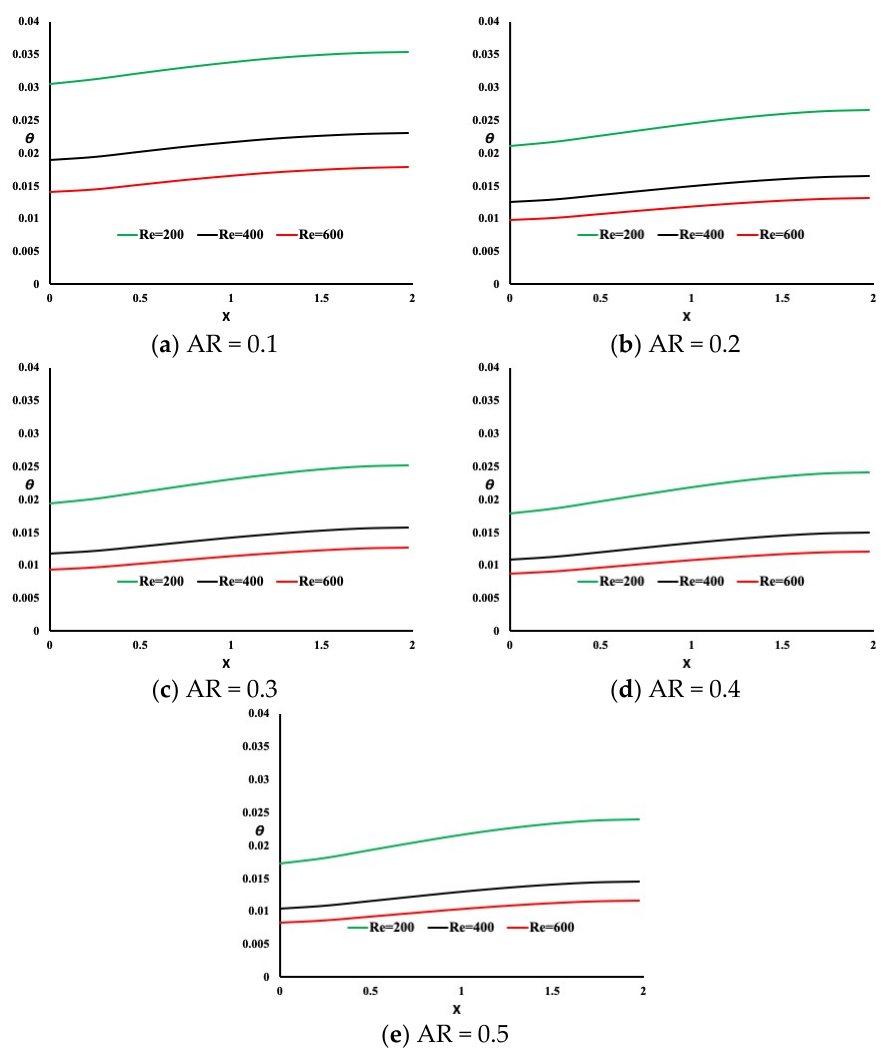
Figure 6. Temperature variation for different aspect ratio.